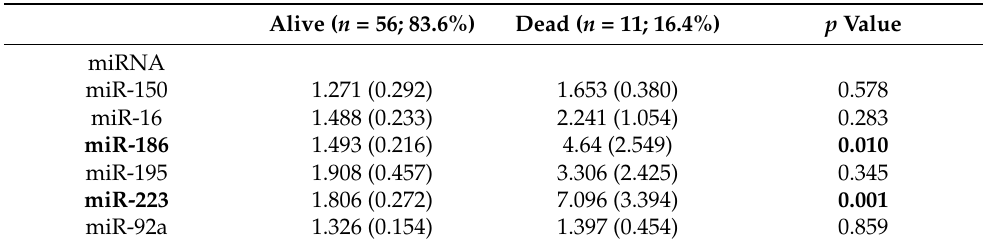
Table 4. Relative miRNA expression levels of MI patients according to vital status.